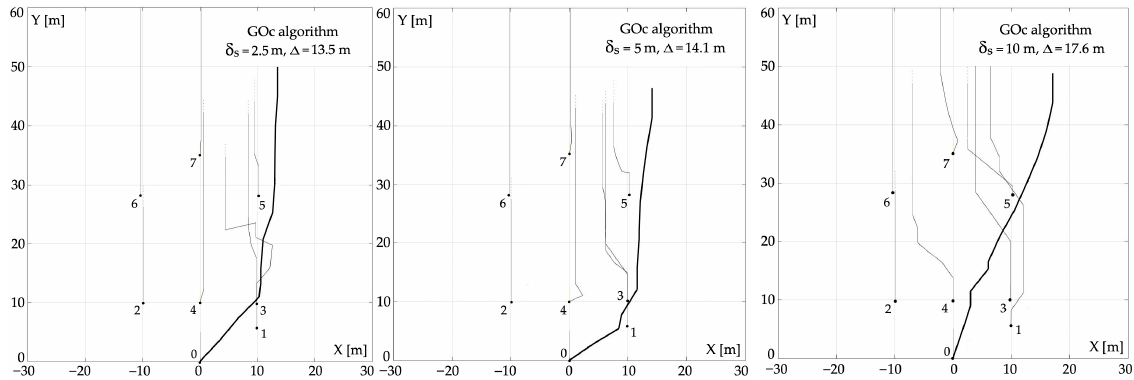
Figure 15. Safe game trajectory of our autonomous vehicle in one-way traffic when passing seven other cooperating autonomous vehicles for three safe passing distance values.